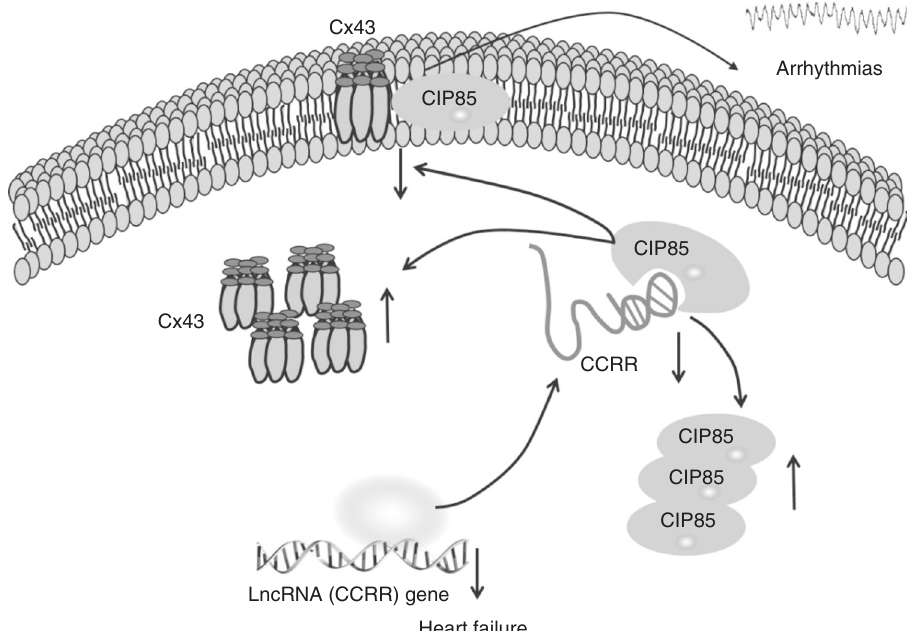
Fig. 10 Schematic illustration of the proposed signaling pathway for CCRR actions. CCRR binds to CIP85 to prevent the binding of CIP85 to Cx43 to reduce the internalization of Cx43 and block CIP85-induced endocytic traf fi cking of Cx43 thereby rescuing the functional presence of Cx43 in the cytoplasmic